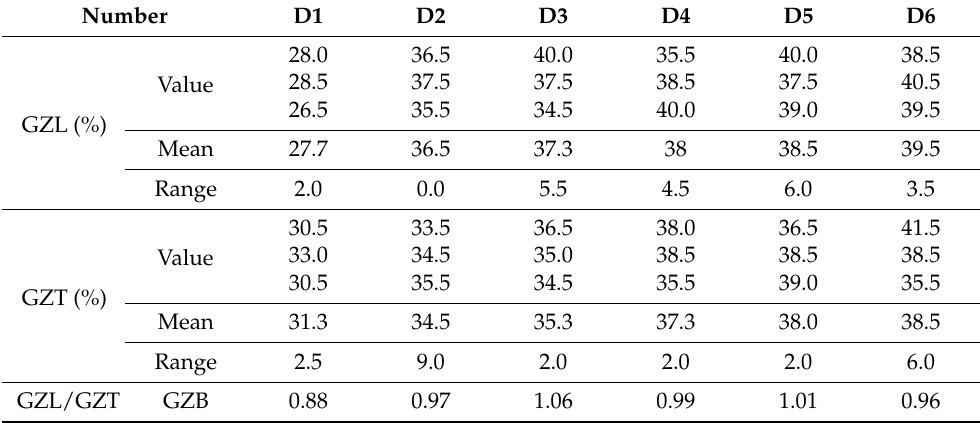
Table 8. The measured value of gloss for Group